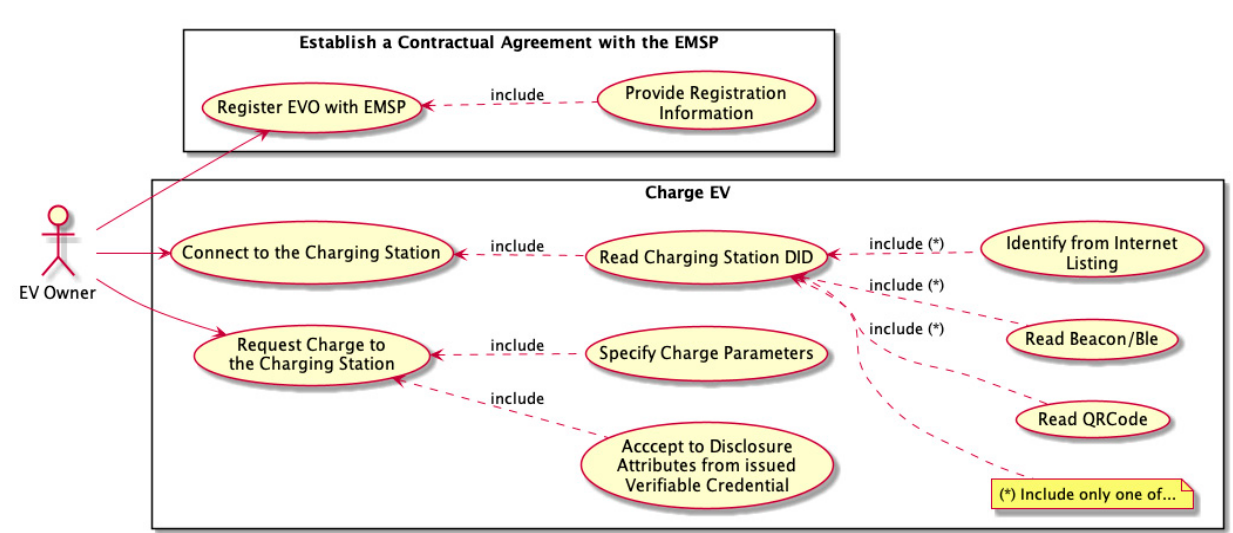
Figure 2. EV owner (EVO) use cases.